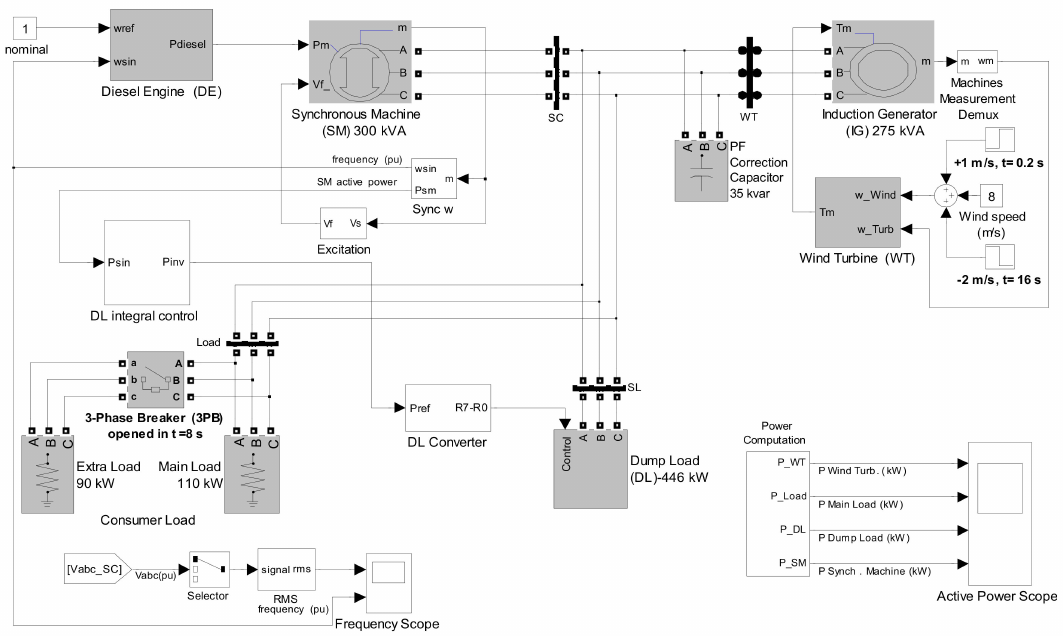
Figure 6. WDIM Simulink